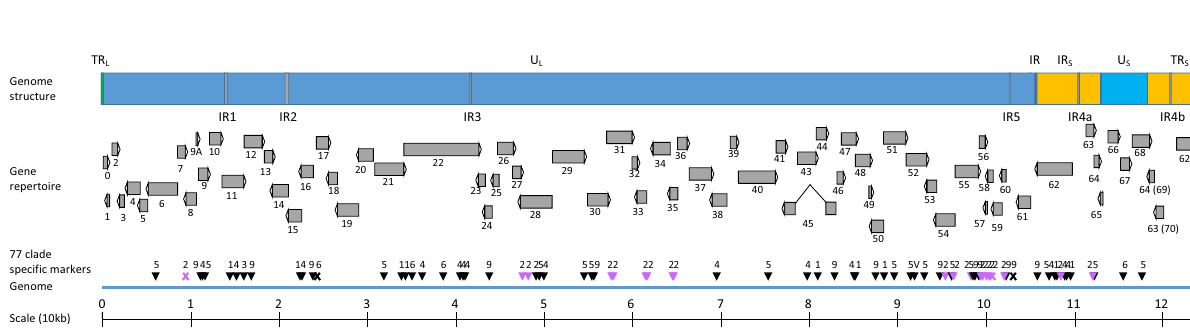
Table 1. Twelve SNPs found only in SD14 genomic sequence.